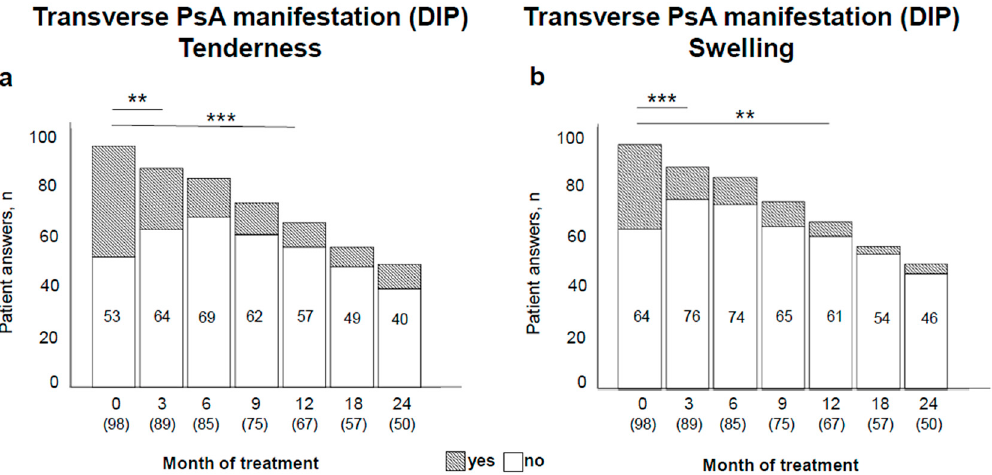
Figure 3. Course of transversal and longitudinal involvement of psoriatic arthritis (PsA) during therapy. In the analysis of